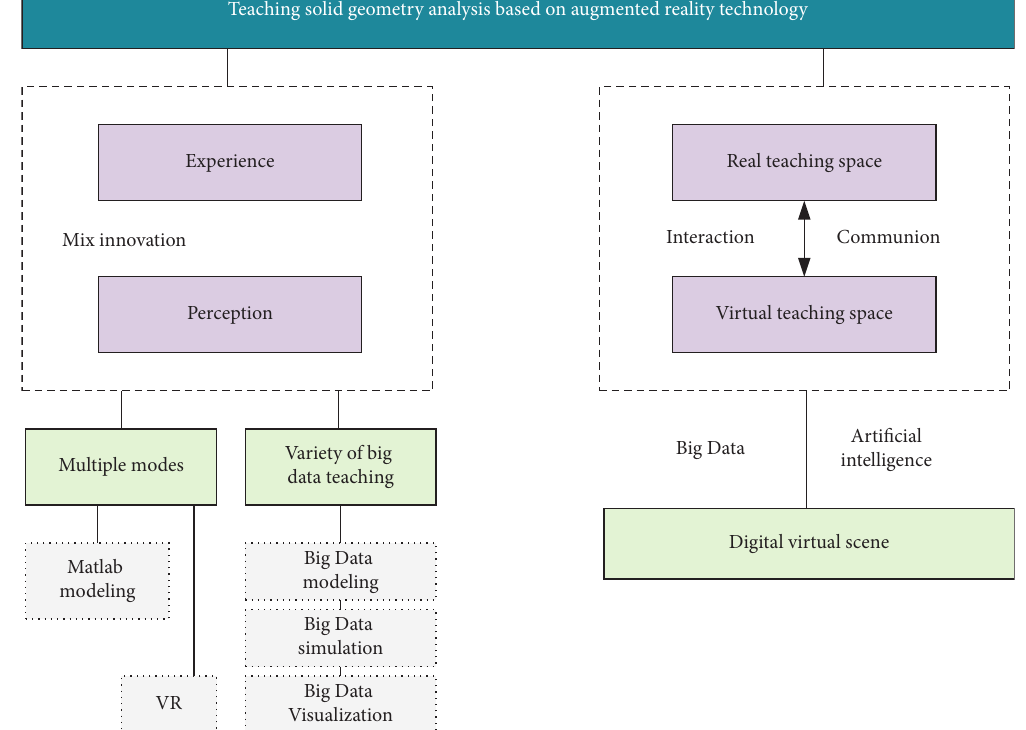
Figure 10: Teaching experience of the augmented reality